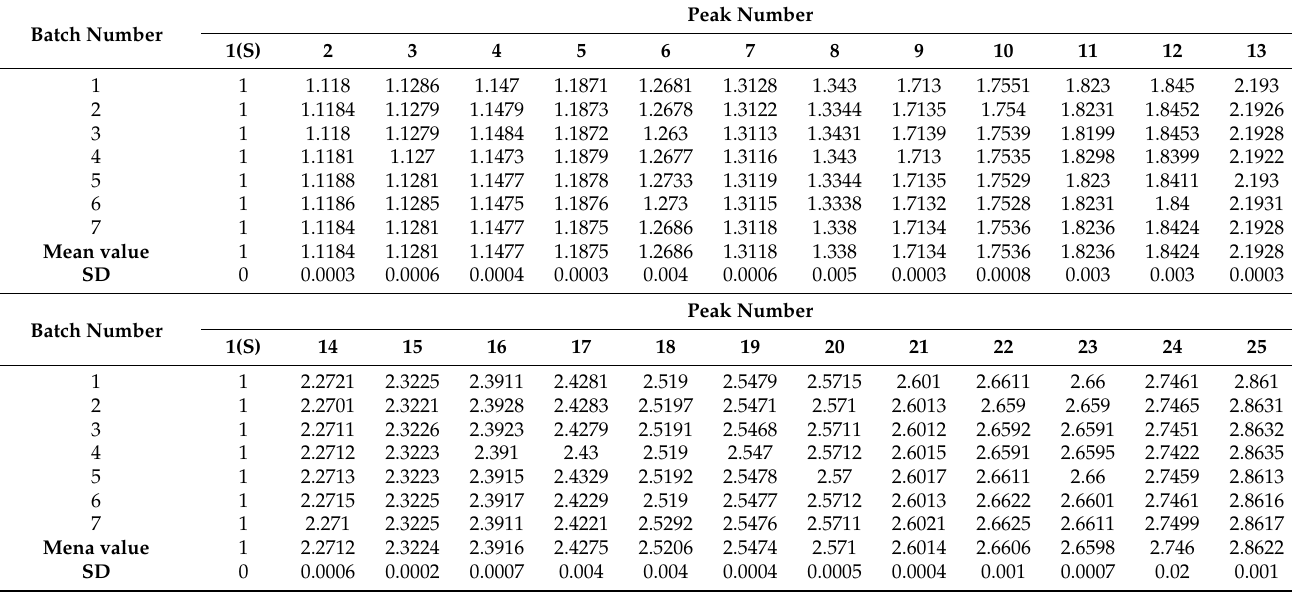
Table 2. Relative retention time of common peaks in seven batches of S. chamaejasme flowers chromatograms. Batch Number